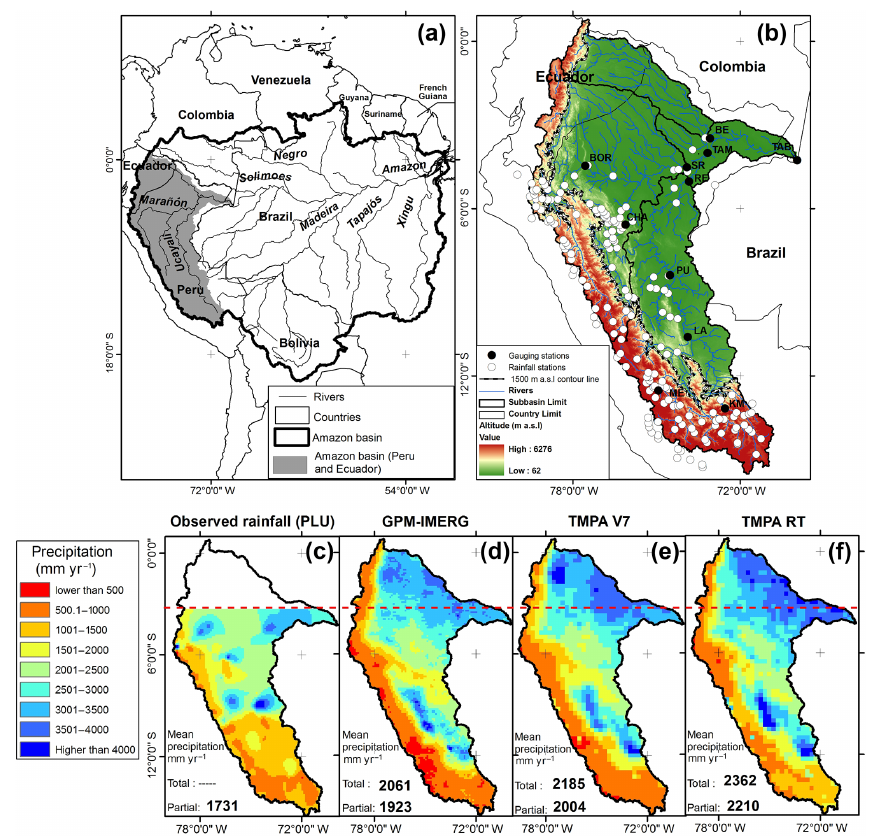
Figure 1. (a) Location of the Amazon Basin in South America. (b) The western Amazon Basin, gauging and rainfall stations used in this work; intermittent line represents main isohypse 1500ma.s.l. Total annual precipitation estimated from (c) observed rainfall-PLU, (d) GPM-IMERG, (e) TMPA V7 and (f) TMPA RT over the Amazon Basin of Peru and